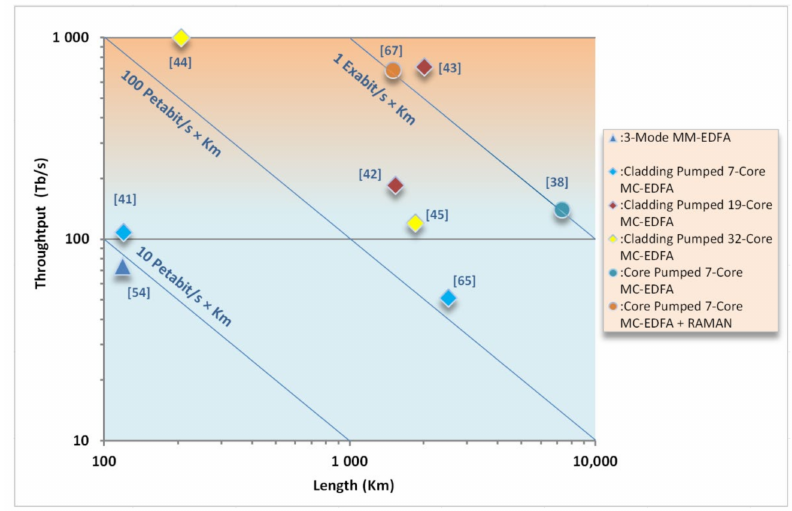
Figure 27. Up-to-date long-haul transmission experiments at transoceanic distances implementing different types of EDFA